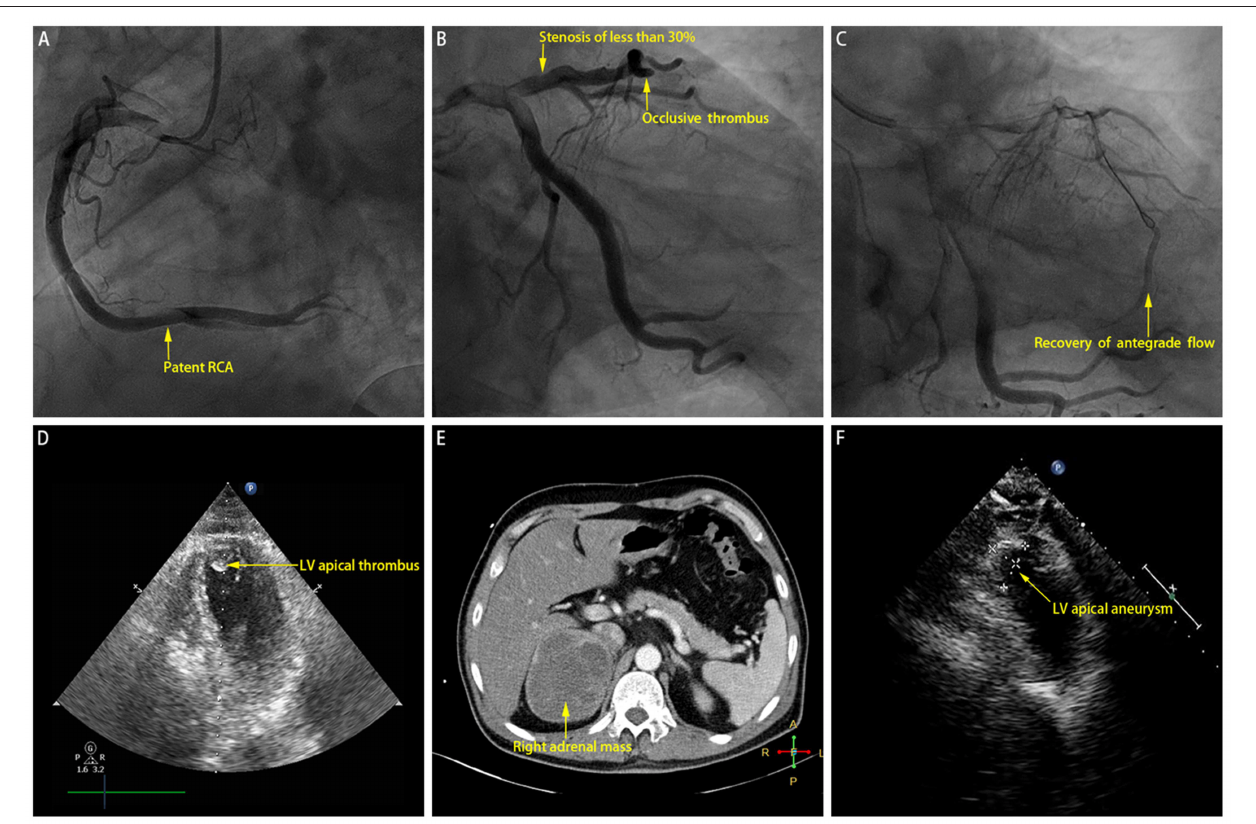
FIGURE 2 | (A) Coronary angiogram revealing patent right coronary artery (RCA). (B) Coronary angiogram revealing minimal stenosis of < 30% near proximal left anterior descending coronary artery (LAD) and occlusive thrombus in distal LAD. (C) Recovery of antegrade flow into distal LAD after manual thrombus aspiration. (D) Index echocardiogram revealing left ventricular (LV) apical thrombus. (E) Computed tomography scan revealing right adrenal mass which is of soft tissue attenuation with heterogeneous contrast enhancement. (F) Echocardiogram performed at the 2-month follow-up revealing left ventricular (LV) apical aneurysm.